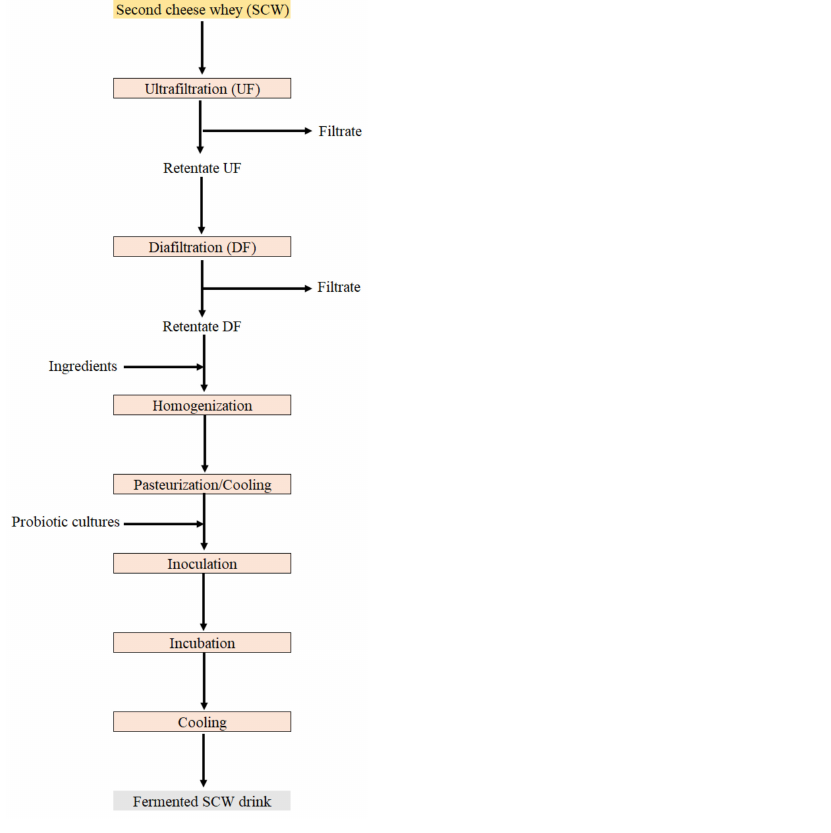
Figure 3. Example of UF/DF applied to SCW for the obtaining of fermented SCW